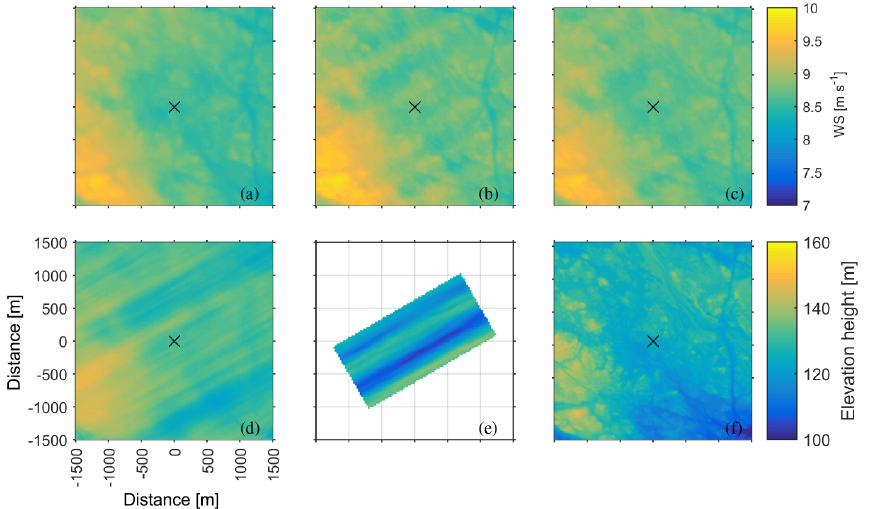
Figure 8. (a–e) Simulated wind speed at 140m above the local ground height. (a) EllipSys3D high-resolution 1, (b) Alya, (c) OpenFoam CFDWind, (d) OpenFoam UUCG, and (e) PALM. The size of the boxes is 3km × 3km centred around the measurement tower (marked by an × ). (f) The elevation